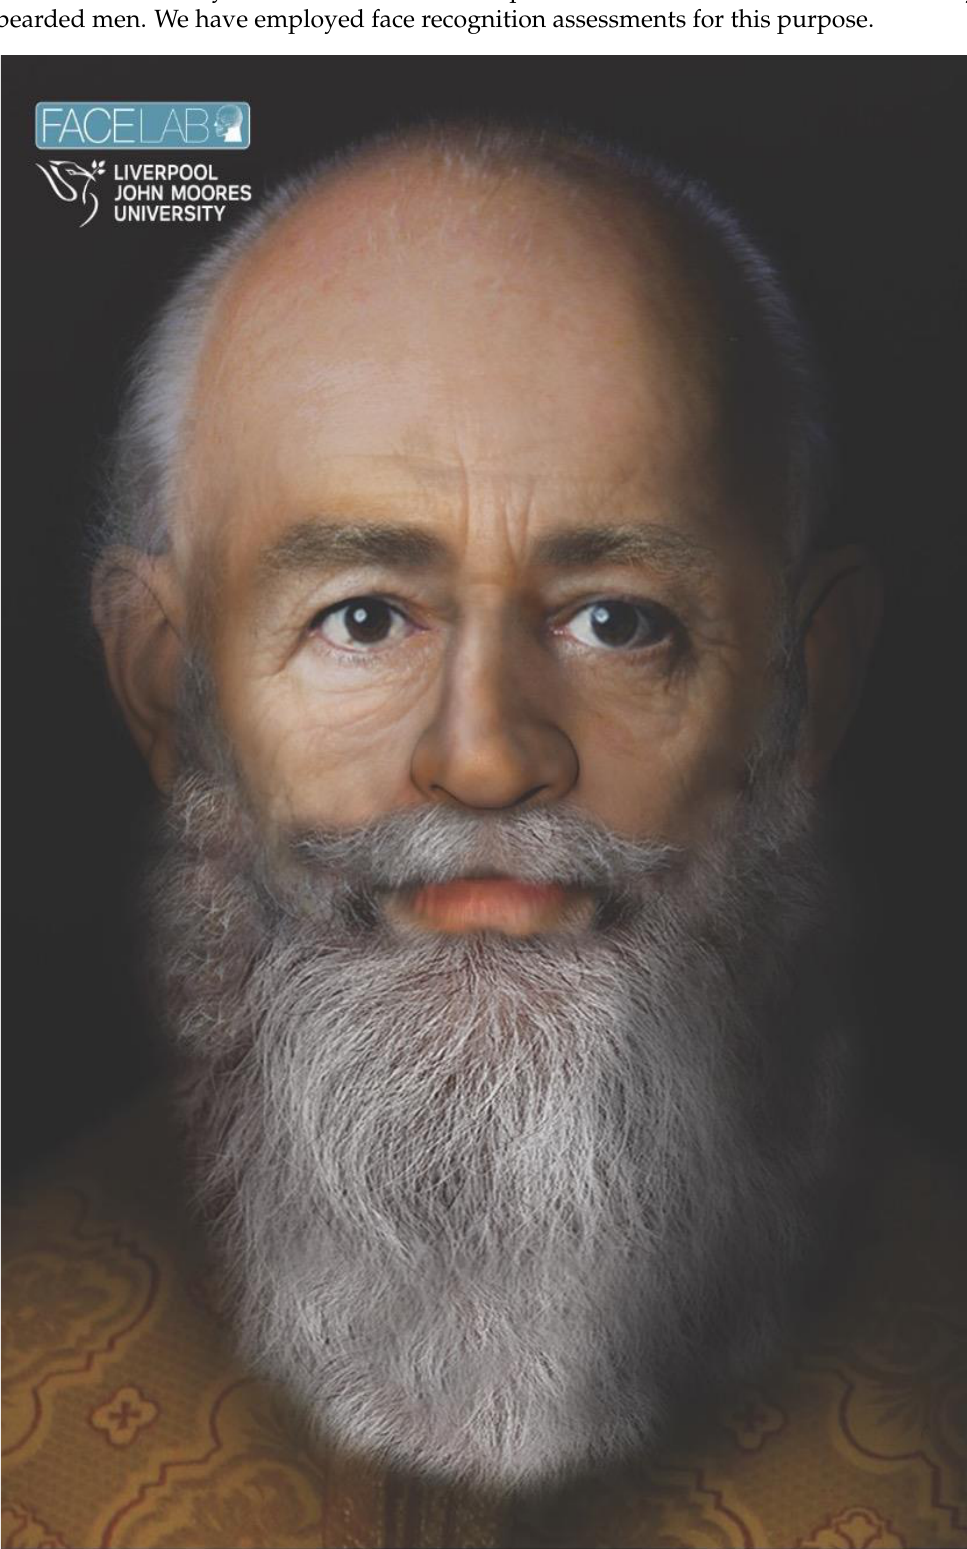
Figure 1. Facial depiction of Saint Nicholas following a forensic facial reconstruction approach based on skull remains (image used with kind permission from Face Lab at Liverpool School of Art & Design, Liverpool John Moores University).